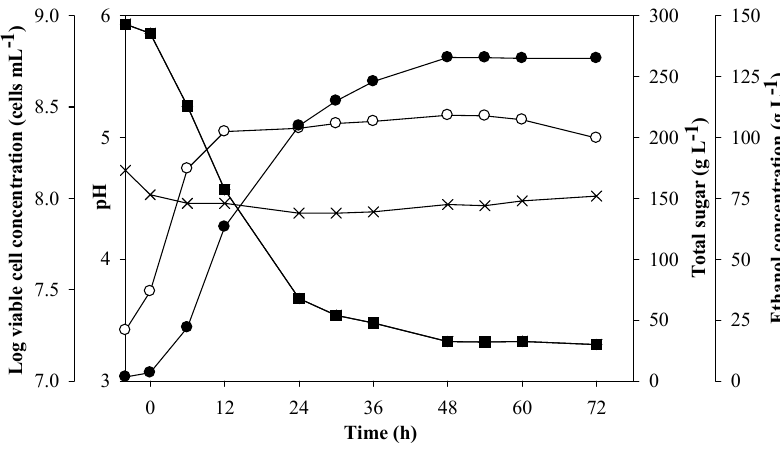
Figure 5. Batch ethanol fermentation in the 2-L fermenter under the optimum condition (agitation rate, 200 rpm; aeration rate, 2.5 vvm and aeration timing, 4 h) from the sweet sorghum juice containing 9 g L − 1 of yeast extract ( ○ = log viable cell concentration, × = pH, (cid:132) = total sugar and ● = ethanol concentration).